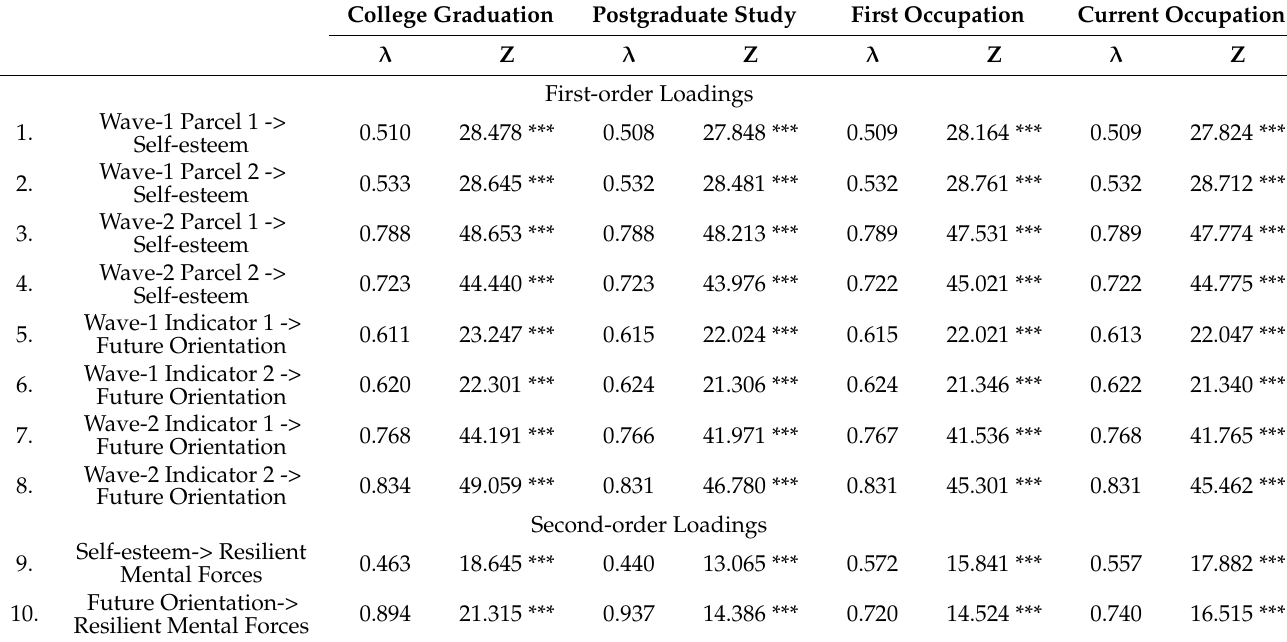
Table 5. Structures and Loadings of the Second-order Latent Factor of Resilient Mental Forces in Immigrant Children across Multilevel